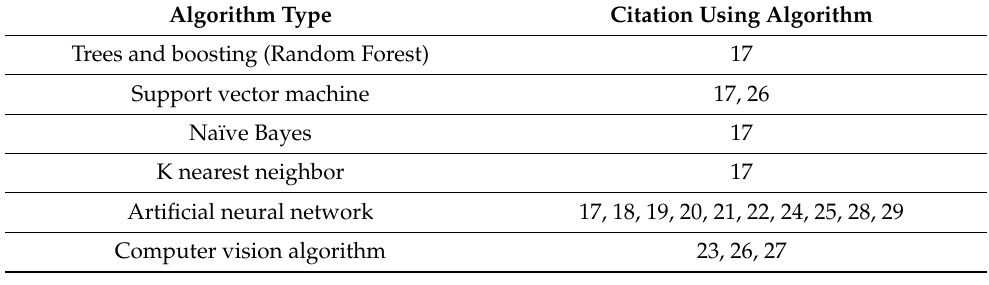
Figure 1. Flow diagram: study identification and screening process.